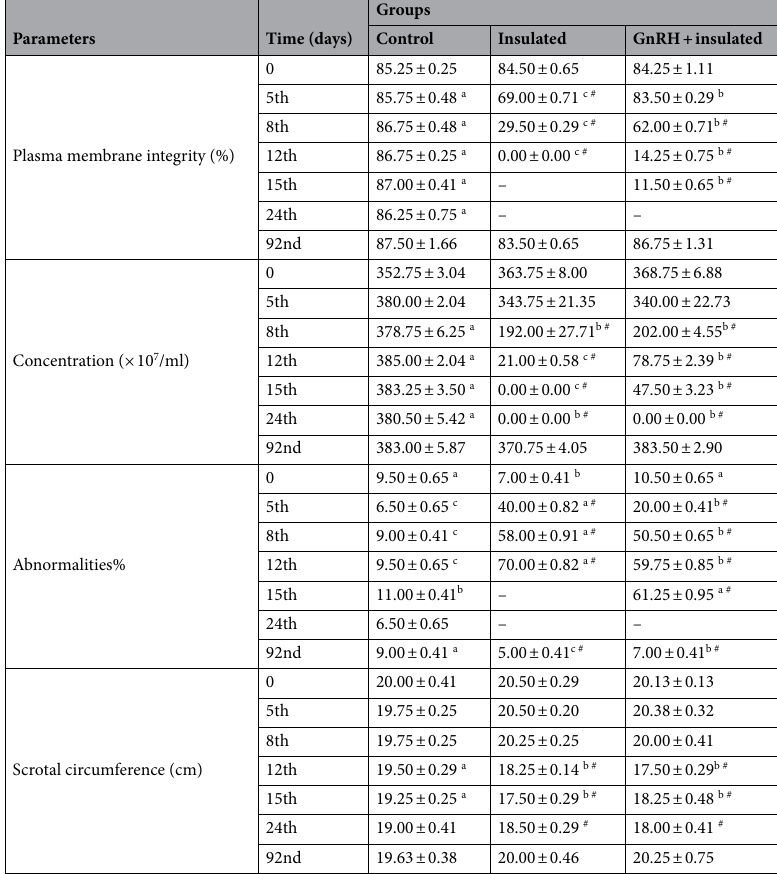
Table 3. Interactions between time and treatment groups on seminal parameters from bucks subjected to scrotal insulation (INS and GnRH + INS) or not (CON) for 92 days of insulation. a,b,c Means with different small superscript letters in the same row are significantly different ( p < 0.05) (Duncan test). # Significant different as compared to zero time in the same group (Paired T-